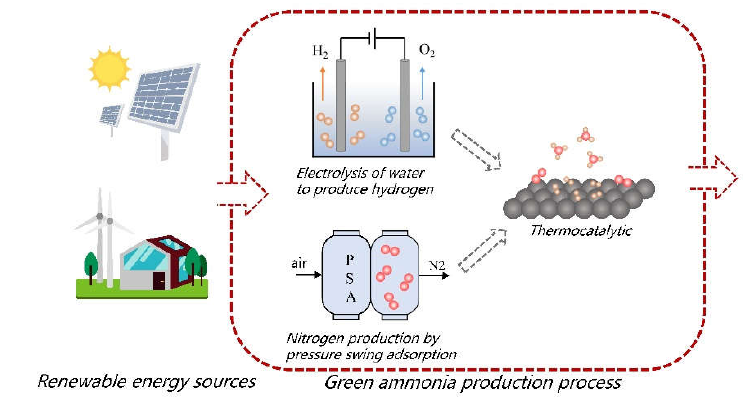
Figure 1. Green ammonia production process technical route.